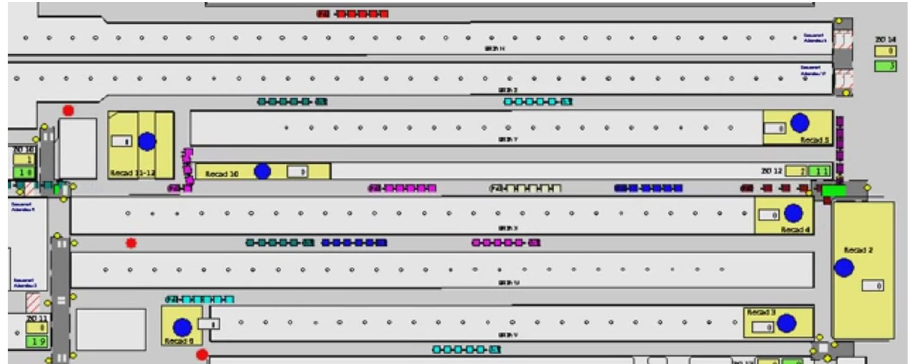
Fig. 9 Example of train simulation in Arena